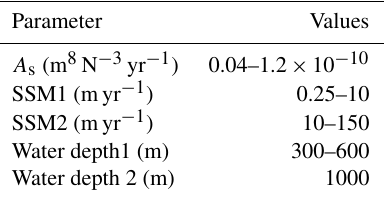
Table 2. Range of parameters adopted in the sub-ice-shelf melting (SSM) parameterizations, illustrated in Fig.